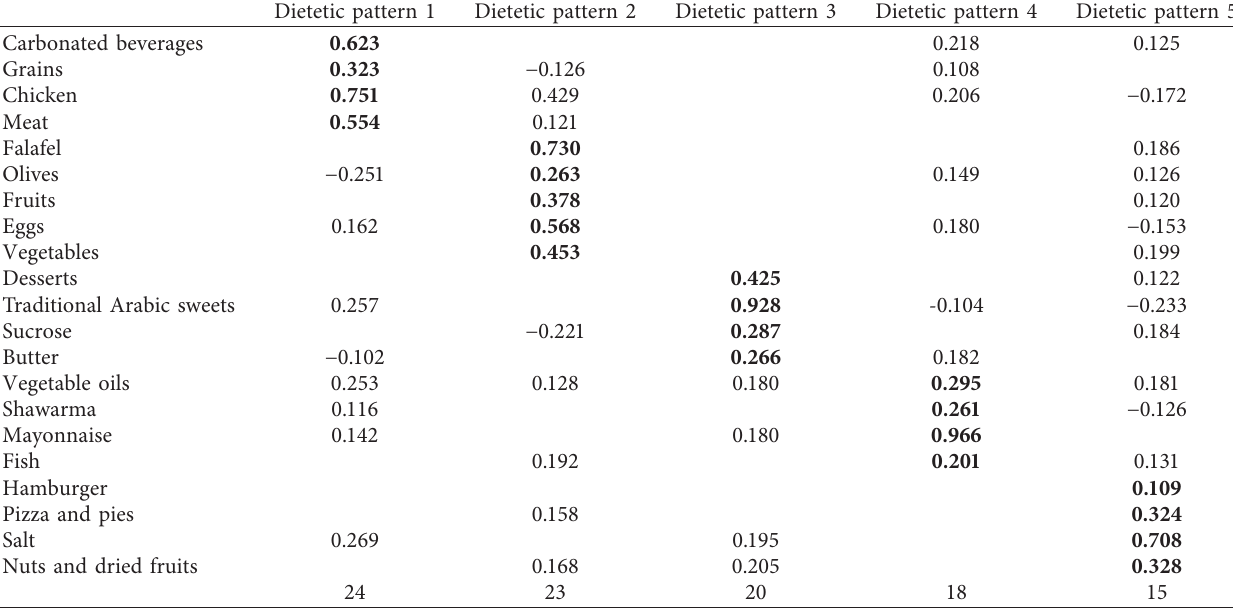
Table 6: Results of the factorial analysis. Loads of each dietary pattern detected in the factorial